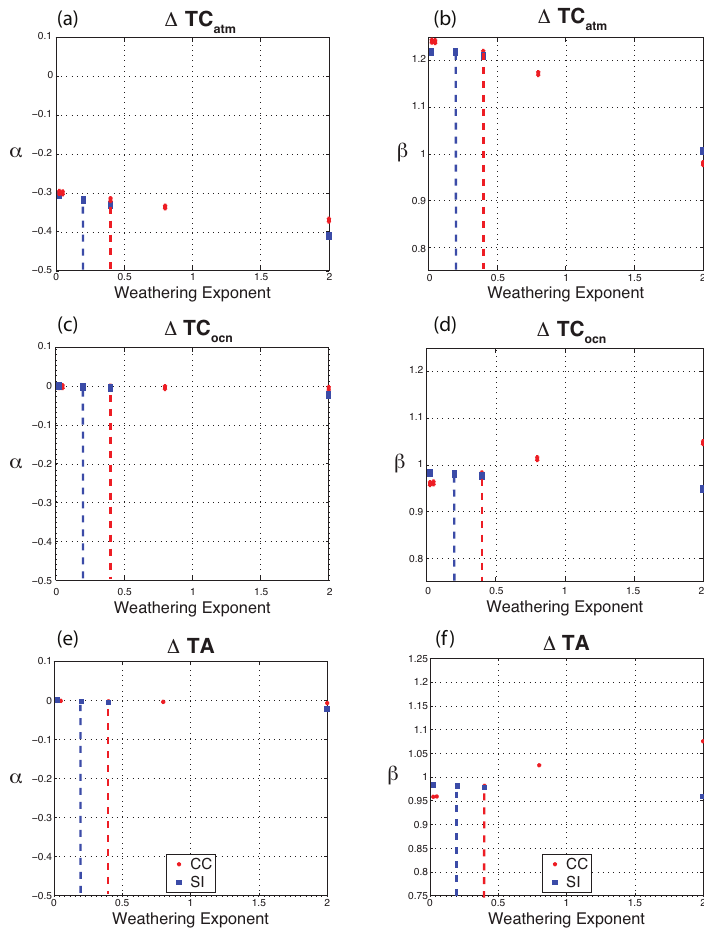
Figure 11. Sensitivity of scaling results to variations in weathering exponents. Dashed lines indicate default LOSCAR exponent values (ncc = 0 . 40; nsi = 0 . 20). (a, b) Peak total atmospheric carbon; (c, d) peak total ocean carbon; (e, f) peak global total alkalinity (TA).